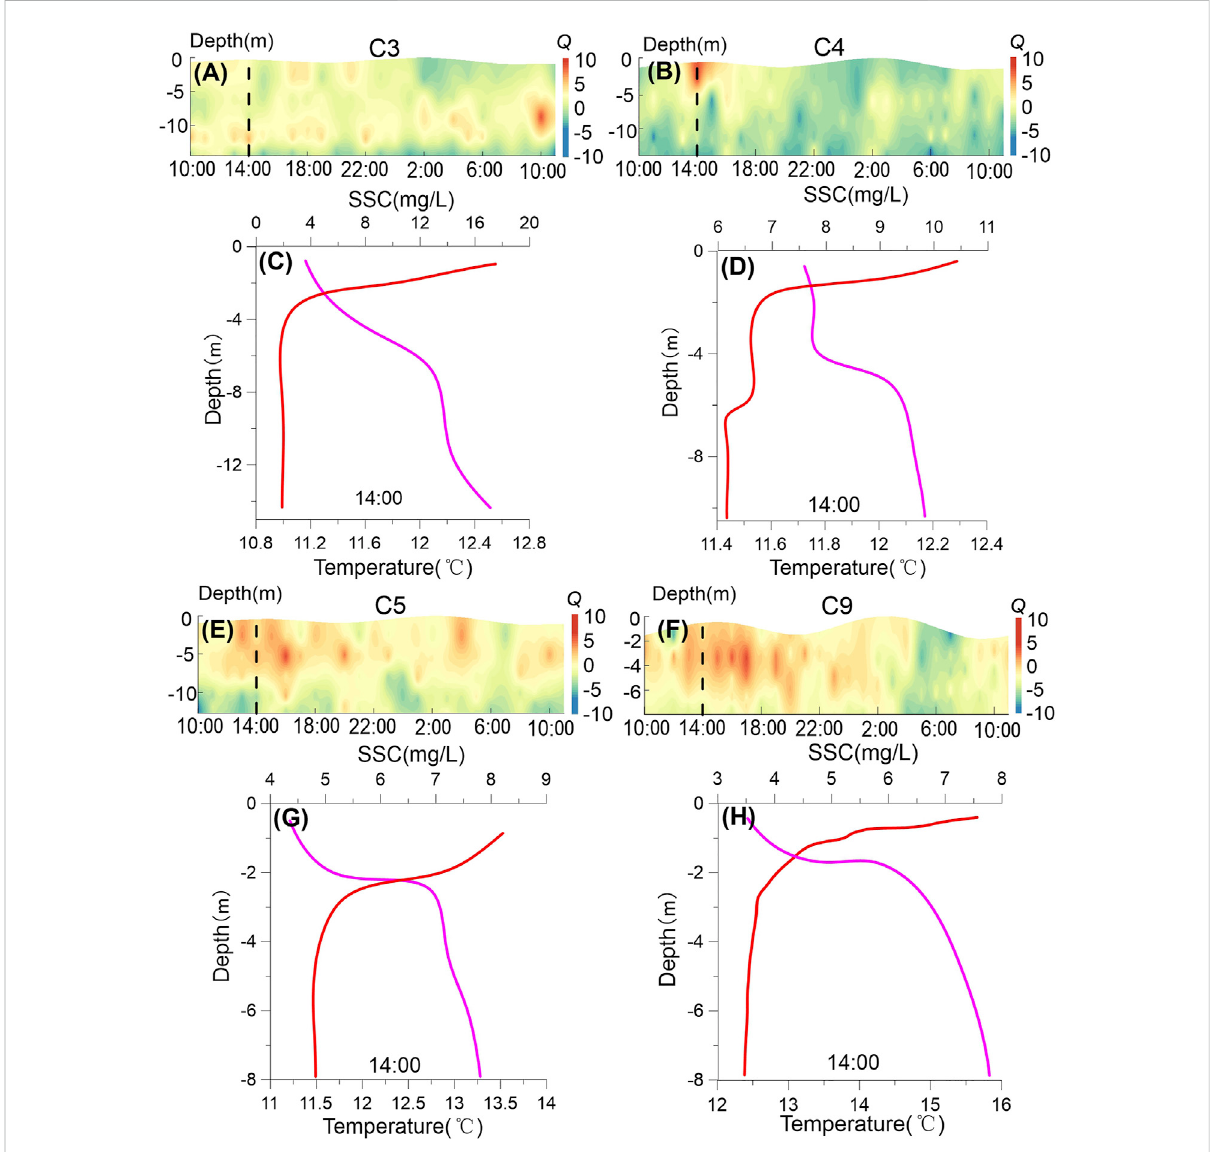
FIGURE 9 The time series diagrams of Q ( Q (cid:1) In ( Rig /0 . 25 ) ) during the moderate tide (A,B,E,F) , the vertical sections of temperature (red line) and SSC (fuchsia line) at 14:00 in April 2020 (C,D,G,H)